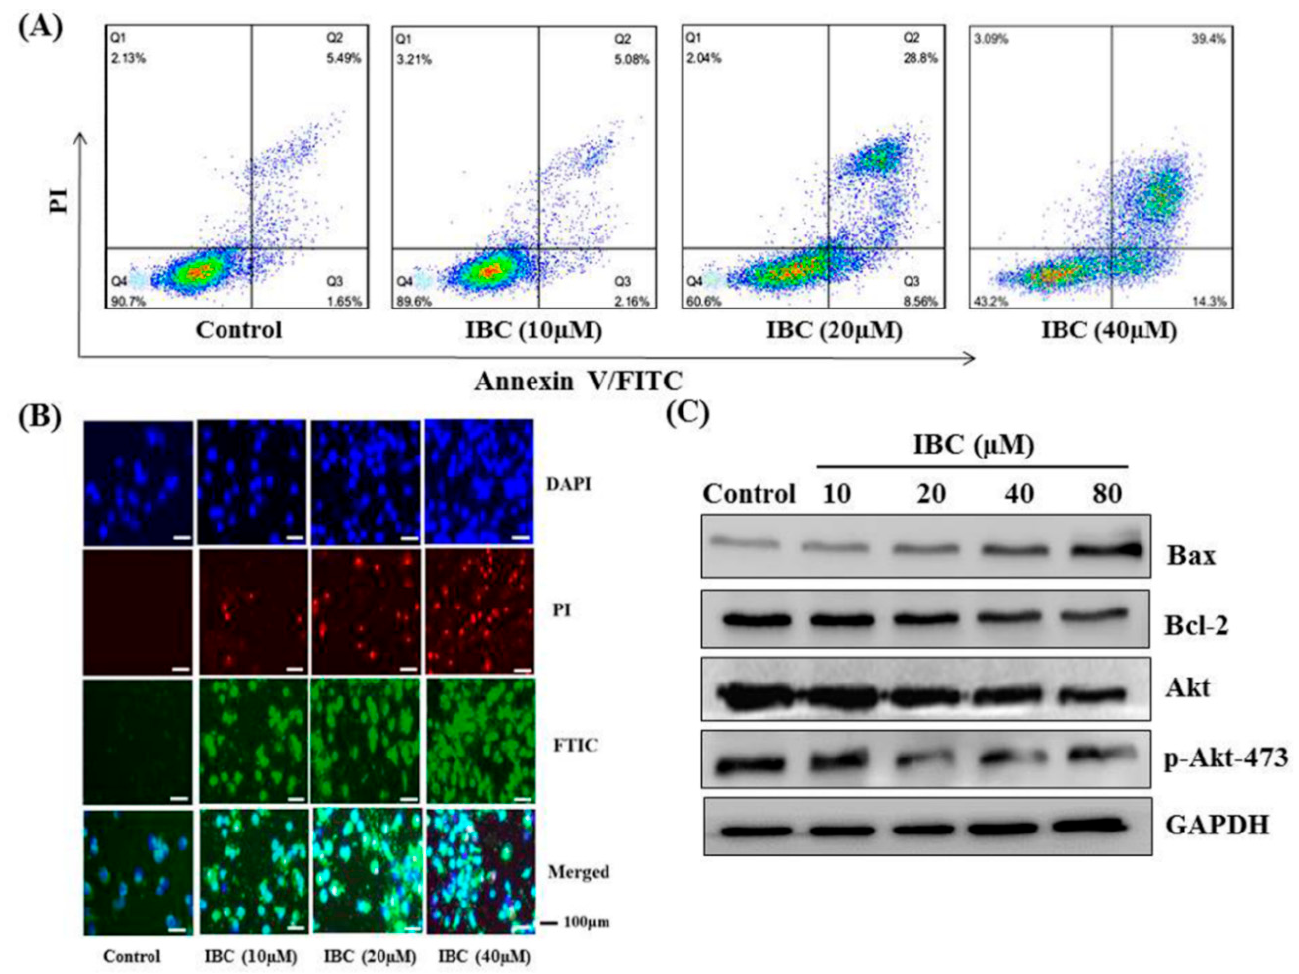
Figure 3. IBC induced apoptosis in human breast cancer MDA-MB-231 cells. ( A ) Flow cytometric analysis of cell death after being treated at different concentrations of IBC using annexin V-FITC/PI dual staining. ( B ) The cells were treated with IBC for 24 h, subjected to DAPI, PI, and FITC staining and visualized using fluorescence microscopy. ( C ) Western blotting analysis of Bax, Bcl-2, Akt, and p-Akt-473 protein levels.